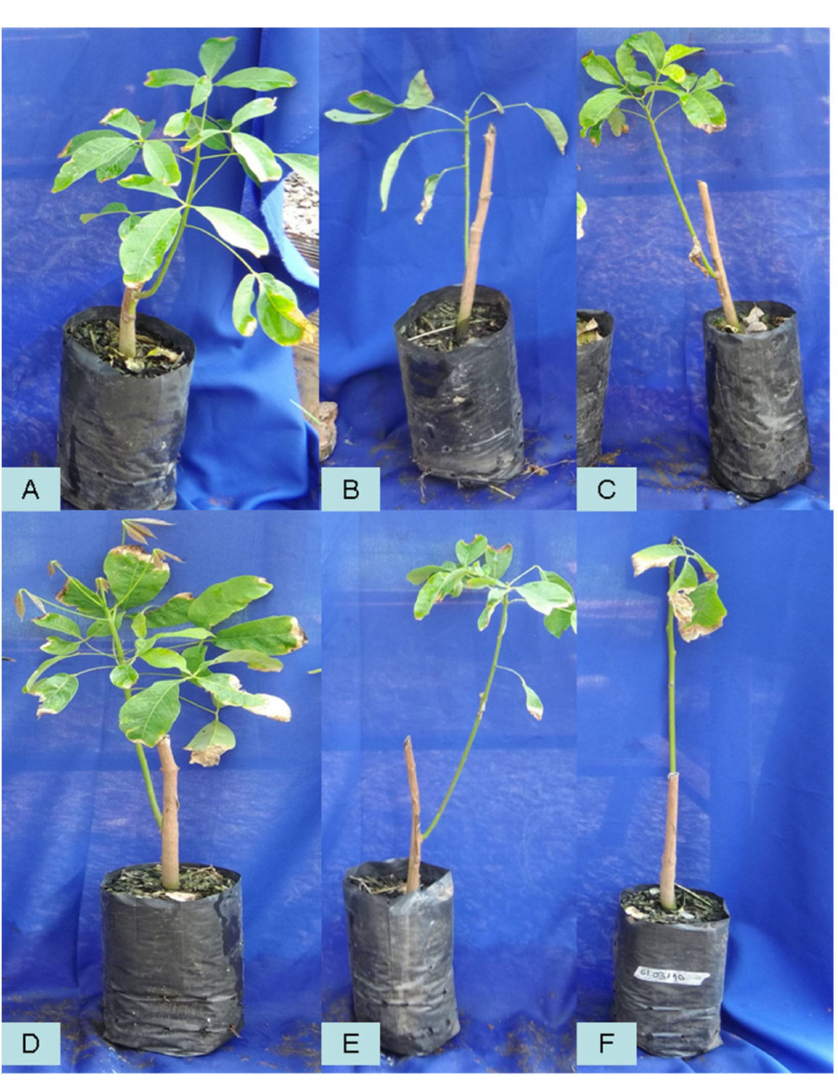
Figure 2. Seedlings of the rubber tree clone RRIM600 after curative treatments with water ( A ), Colletotrichum alone ( B ), P. macrosporus —Isolate 37/06 ( C ), C. eragrostidi —Isolate 47/06 ( D ), M. levis- pora —Isolate 33/08 ( E ), and M. roridum —Isolate 03/10 ( F ).